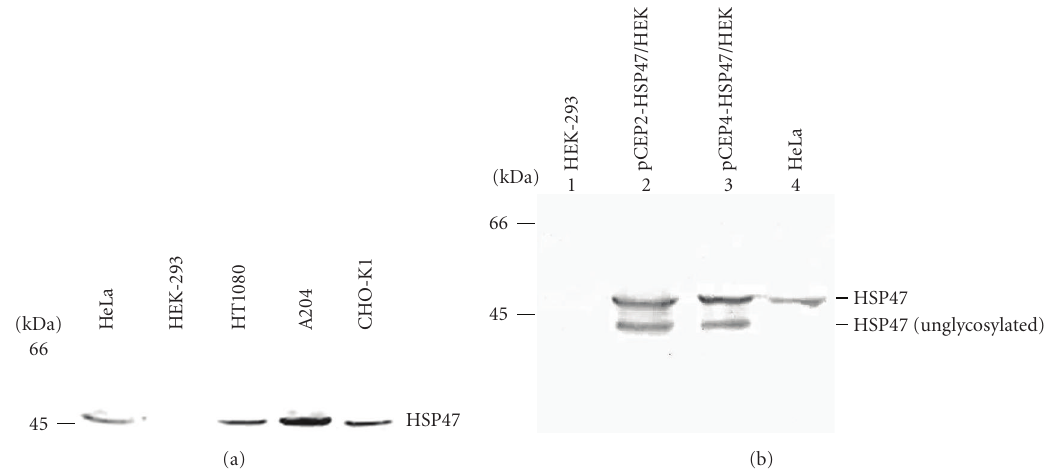
Figure 5: (a) HSP47 expression in di ff erent cell lines. Western blot analysis of conditioned cell lysates from di ff erent cell lines probed with monoclonal antibody to HSP47. Left, molecular mass standards expressed in kDa. (b) Western blot analysis of HSP47 expression in untransfected HEK-293 cells (lane 1), HEK-293 cells transfected with pCEP2-HSP47 (lane 2) or with pCEP4-HSP47 (lane 3) constructs and in HeLa cell lysate as positive control (lane 4). Two bands were detected in transfected HEK-293 cells lysates corresponding, respectively, to the glycosylated and unglycosylated forms. Left, molecular mass standards expressed in